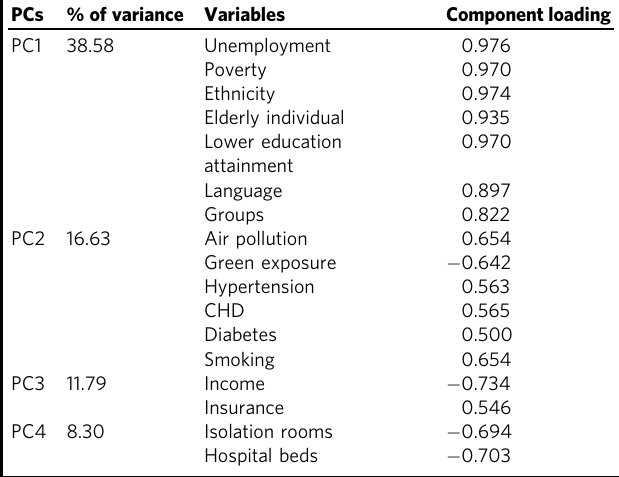
Table 1 Principal component analysis results. PCs % of variance Variables Component loading PC1